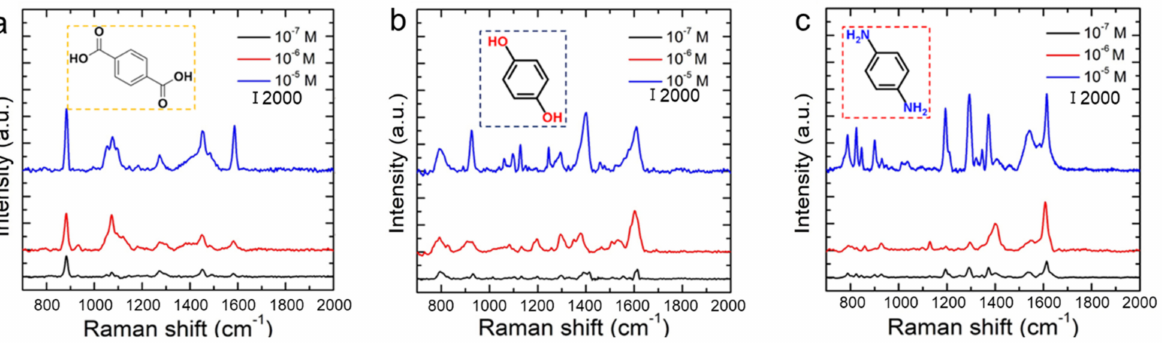
Figure 5. SERS detection of organic pollutants. ( a ) SERS spectra obtained using different con- centrations, from 10 − 5 to 10 − 7 M, of terephthalic acid. ( b ) SERS spectra obtained using different concentrations, from 10 − 5 to 10 − 7 M, of hydroquinone. ( c ) SERS spectra obtained using different concentrations, from 10 − 5 to 10 − 7 M, of